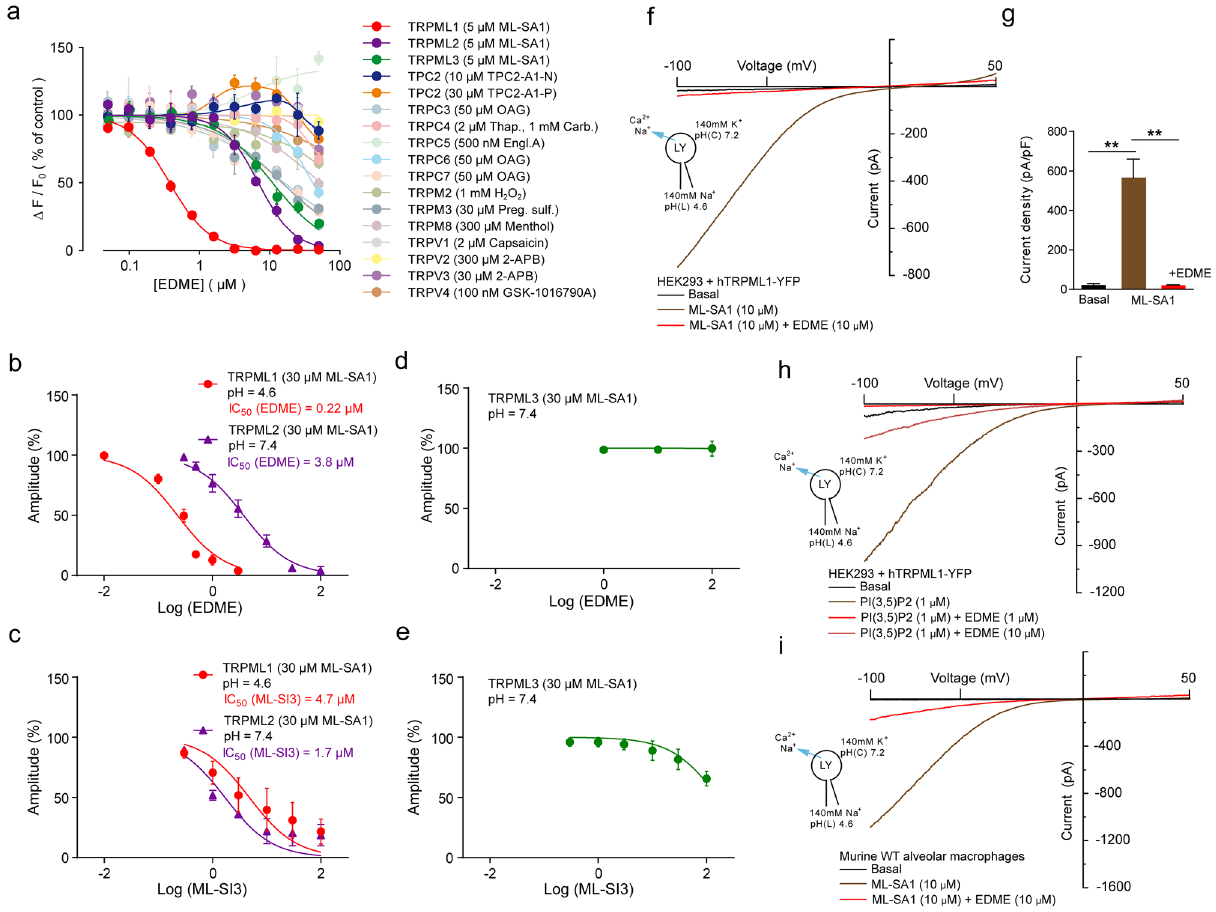
Figure 2. EDME is a potent and selective blocker of TRPML1. ( a ) Representative concentration-effect relationships for Ca 2+ increases (Fluo-4) in response to different concentrations of EDME on HEK293 cells stably expressing different TRP channels including hTRPML1∆NC, 2, 3, or TPC2, respectively. Corresponding activators for each TRP channel are listed in parentheses. ( b – e ) Concentration-effect relationships obtained from whole-cell patch-clamp measurements showing effect of EDME ( b , d ) and the previously described non- selective TRPML blocker ML-SI3 ( c , e ) on hTRPML1L15/16A, L577/578A (pH 4.6; n = 6, each), hTRPML2 (pH 7.4; n = 4, each), and hTRPML3 (pH 7.4; n = 3, each) in the presence of 30 µM ML-SA1. Current recording was done with WinWCP5.2.7 (University of Strathclyde, UK) software, and analysis was done with the help of a customized Igor pro program (WaveMetrics). ( f ) Endolysosomal patch-clamp experiment showing effect of EDME on WT hTRPML1 after activation with ML-SA1 (10 µM). ( g ) Statistical analysis for experiments as shown in ( f ) (luminal pH 4.6; n = 3, each). P-values were calculated by one-way ANOVA followed by Tukey’s post hoc test. **p-value < 0.01. ( h ) Endolysosomal patch-clamp experiment showing effect of EDME on WT hTRPML1 after activation with the endogenous ligand PI(3,5)P 2 (1 µM). ( i ) Endolysosomal patch- clamp experiment showing effect of EDME (10 µM) on TRPML1 endogenously expressed in mouse alveolar macrophages after activation with ML-SA1 (10 µM). All endolysosomal patch-clamp experiments were analyzed using PatchMaster acquisition software (https:// www. heka. com/) and OriginPro 6.1 (https:// www. origi nlab. com/). All statistical analysis was done using GraphPadPrism software (https:// www. graph pad. com/ scien tific- softw are/